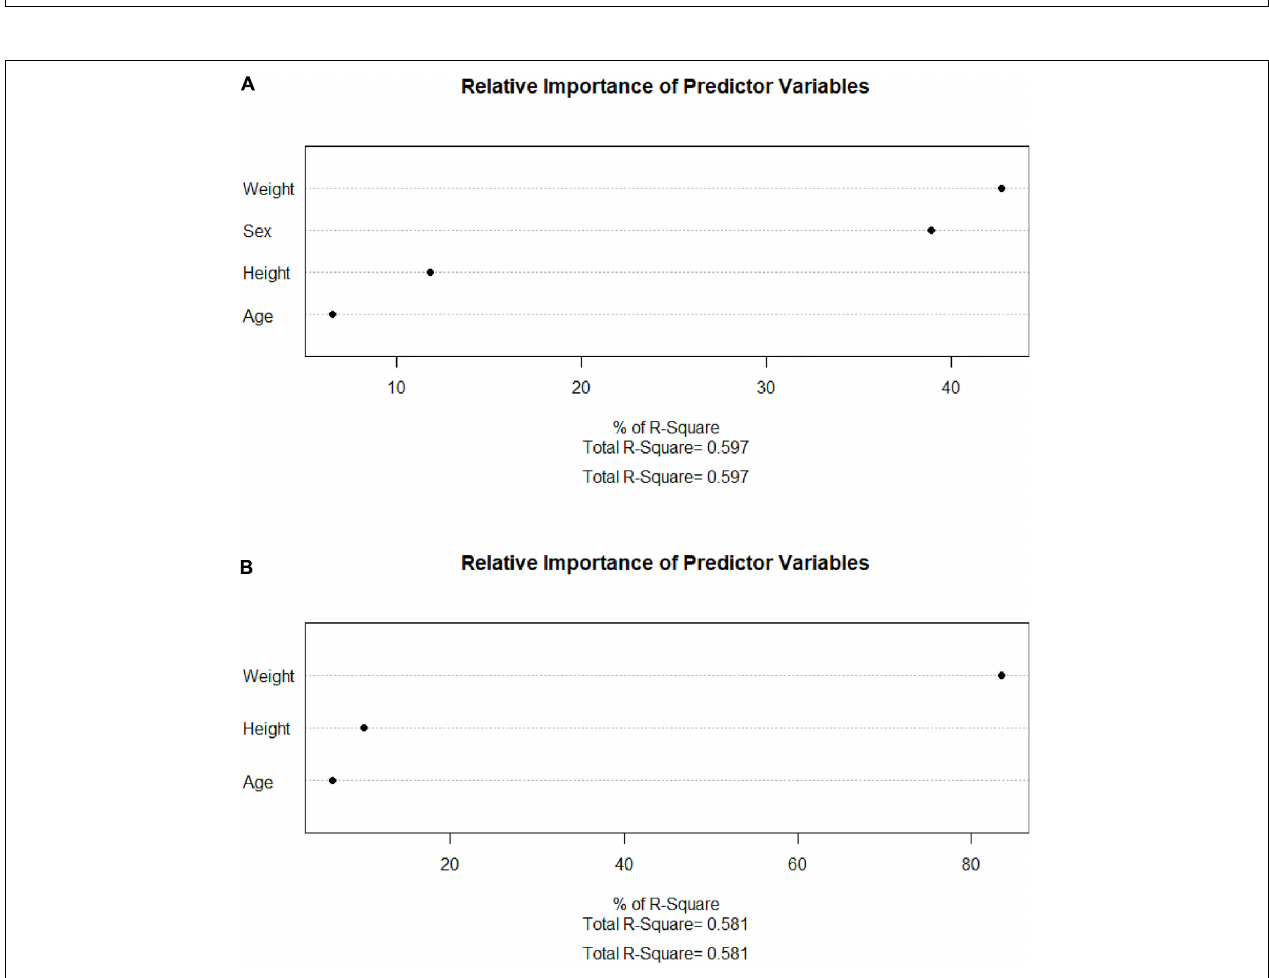
FIGURE 2 | All subsets regression of SMI and VFA. (A) SMI. (B) VFA. SMI: skeletal mass index at the third lumbar; VFA: visceral fat area.